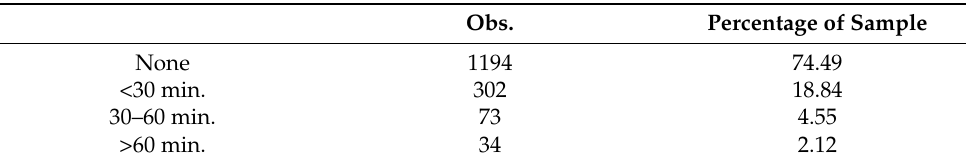
Table A1. Average daily video game time among sample adolescents (minutes).